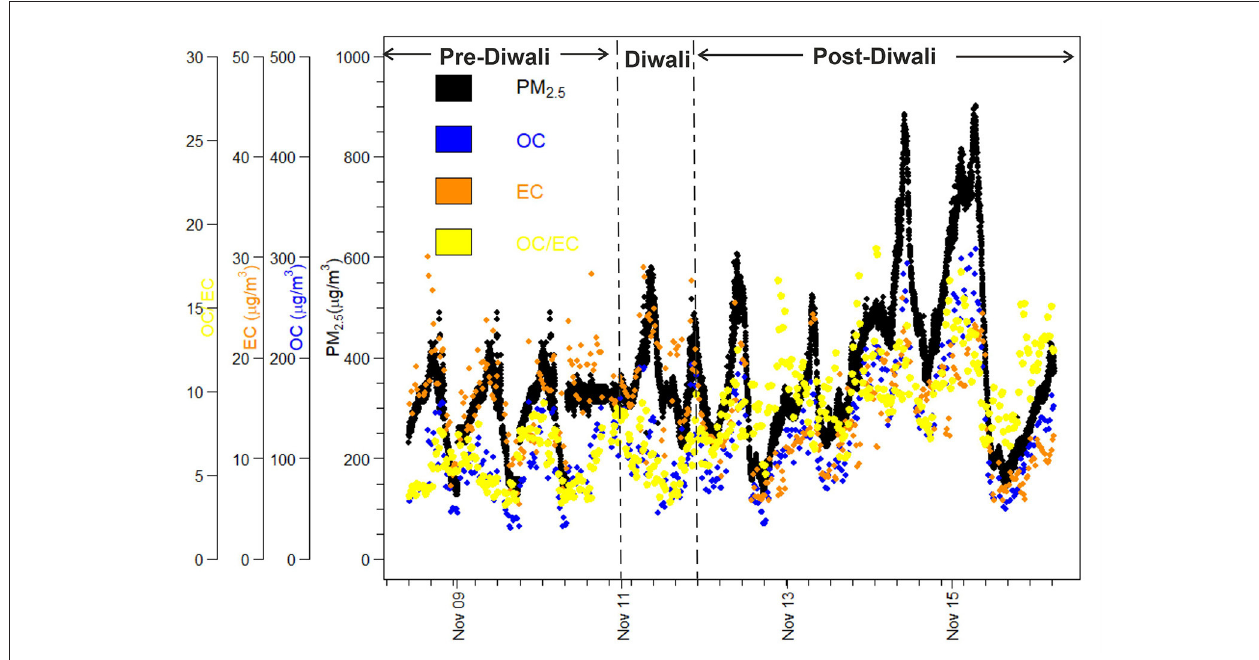
FIGURE 2 | Temporal variability in mass concentrations of PM 2.5 OC, EC, and OC/EC ratio during the study campaign (08th − 16th Nov. 2015).